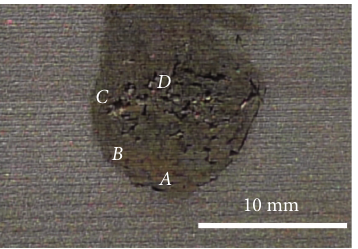
Figure 8: OM image of the head of 93W alloy residual